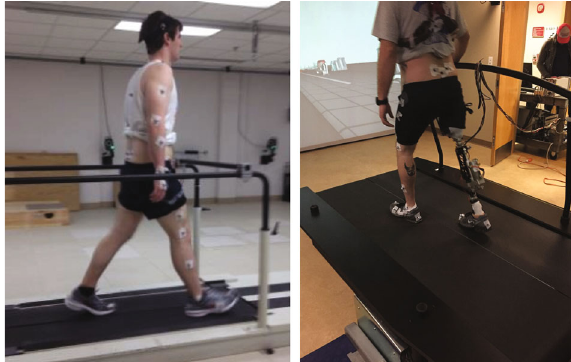
Figure 2: Walking kinematics and kinetics were captured on a force instrumented treadmill.